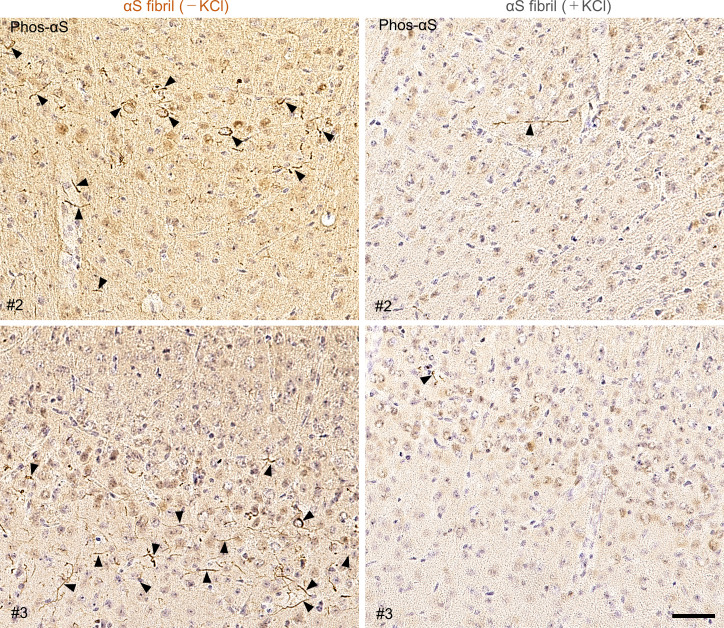
Images of cortex of other two mice injected with the α-synuclein fibrils.Distribution of phosphorylated α-synuclein pathology in mouse brain. α-synuclein fibrils (-) or α-synuclein fibrils (+) were injected into three mice each and stained with phosphorylated α-synuclein antibodies 1 month after injection. Representative images of cortex of other two mice (#2 and #3), not shown in Figure 2, are shown. Typical pathological α-synuclein deposits are indicated by the arrowheads. Sections were counterstained with hematoxylin. Scale bar, 50 µm.